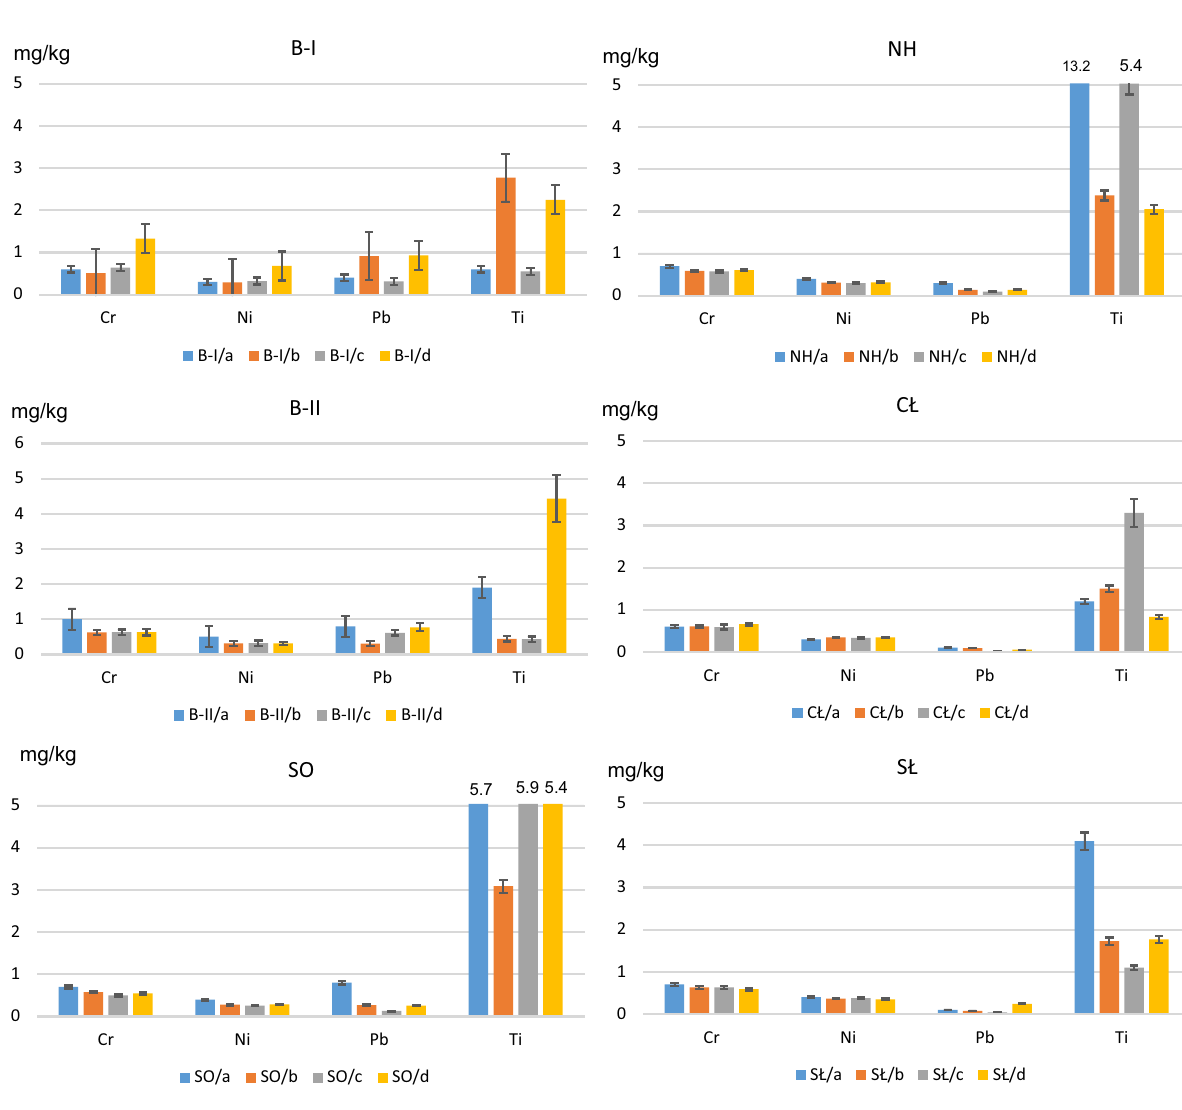
Figure 7. The content of Cr, Ni, Pb and Ti in lettuce, growing on: a —unfertilized soil, b —mix of straight fertilizers, c —multinutrient fertilizer and d —organic fertilizer. B-I, B-II—Bukowno region, SO—Sosnowiec, NH, CŁ—Nowa Huta region, SŁ—control